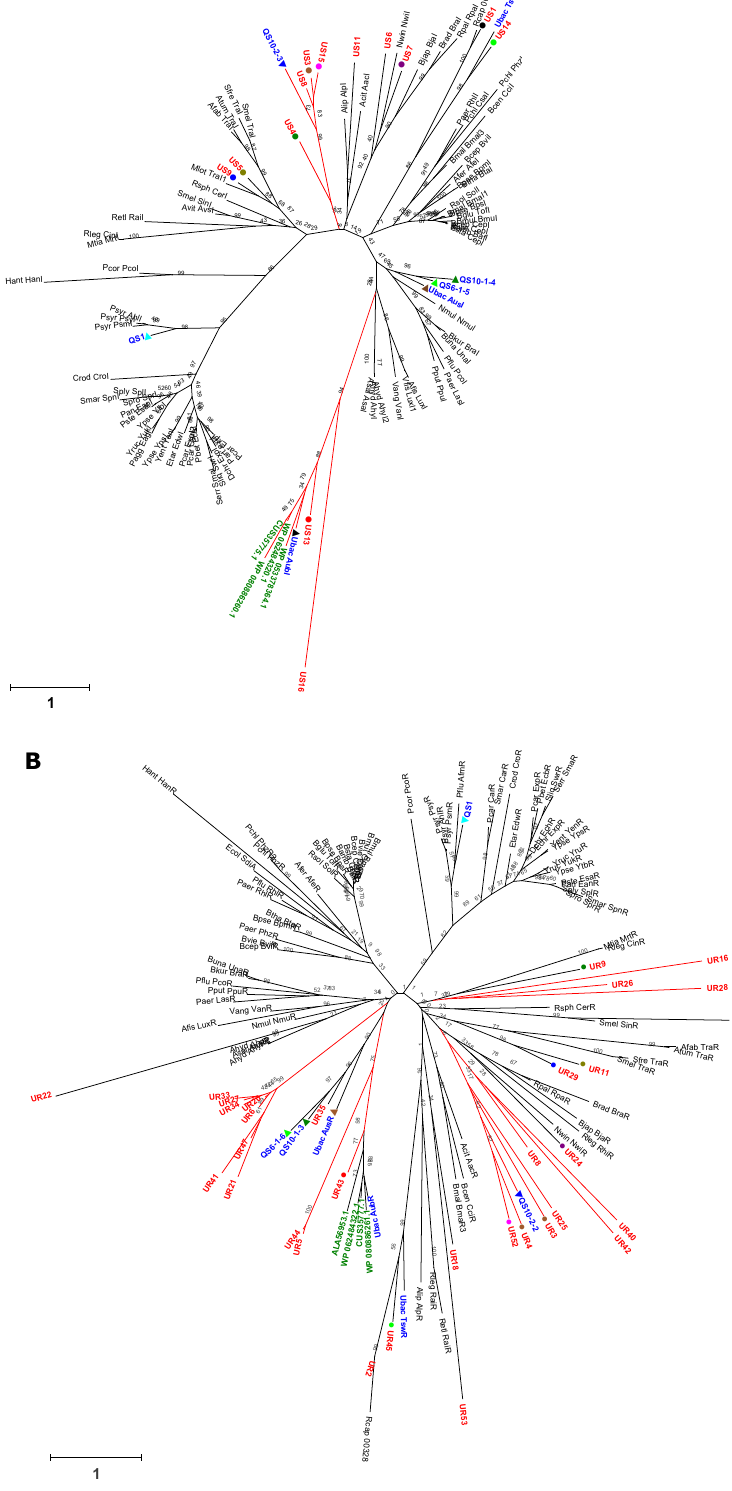
Fig. 2 Phylogenetic tree illustrating the evolutionary relationship of the metagenomic luxI and luxR constructed using the maximum- likelihood method. Phylogenetic analysis was performed by comparing the amino acid sequences of the metagenomic luxI genes ( a ) and metagenomic luxR genes ( b ) to 80 and 85 functionally veri fi ed luxI and luxR that were previously reported in the literature, as well as four luxI / R pairs obtained from Nitrospira . The luxI / R homologs veri fi ed in pure culture studies, metagenome studies, and other Nitrospira were written in black, blue, and green, respectively, while the putative luxI / R homologs identi fi ed in this study was written in red. The paired luxI / R homologs were indicated by symbols with the same shape and